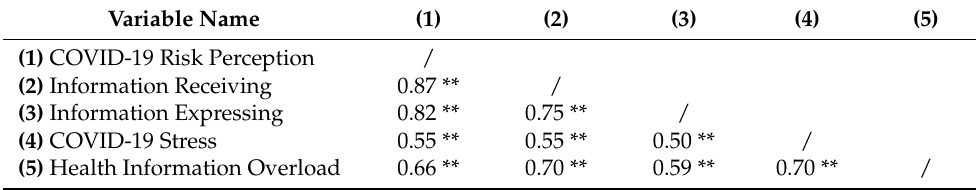
Table 1. Bivariate correlations between measured variables (N = 676).